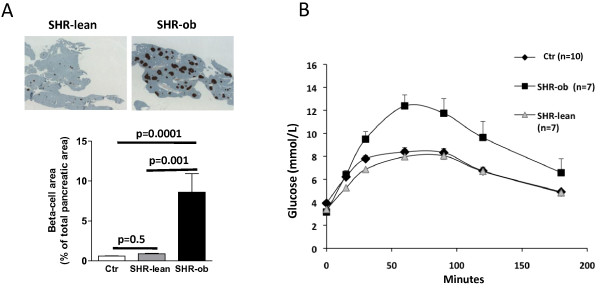
A) Beta islet cell detection and quantification in pancreatic tissue via insulin immunohistochemistry (pancreatic beta-cell areas of total pancreatic area) in controls (Ctr), SHR-lean and SHR-ob rats. B) Oral glucose tolerance testing in controls (Ctr) (n = 10), SHR-lean (n = 7) and SHR-ob (n = 7) for comparison. Data are presented in means ± SEM.